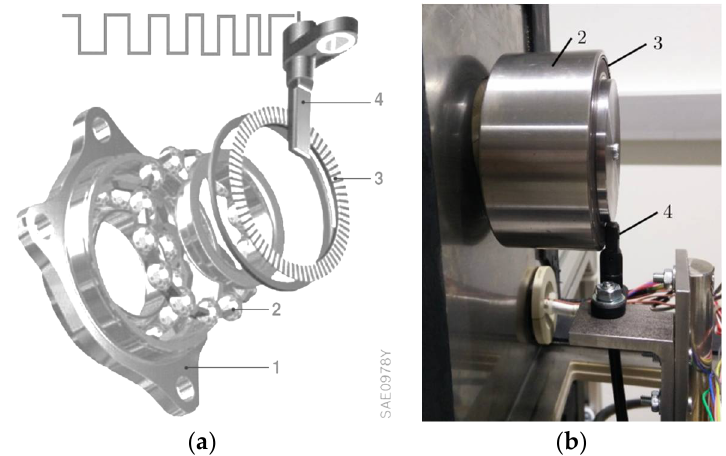
Figure 8. Hall-based wheel speed sensor. (1) wheel hub, (2) ball bearing, (3) permanent magnet ring, (4) wheel speed sensor. ( a ) Exploded assembly drawing, reproduced from [9]. Copyright 2007, Robert Bosch GmbH.; ( b ) Exemplary sensor on the sensor test bench.